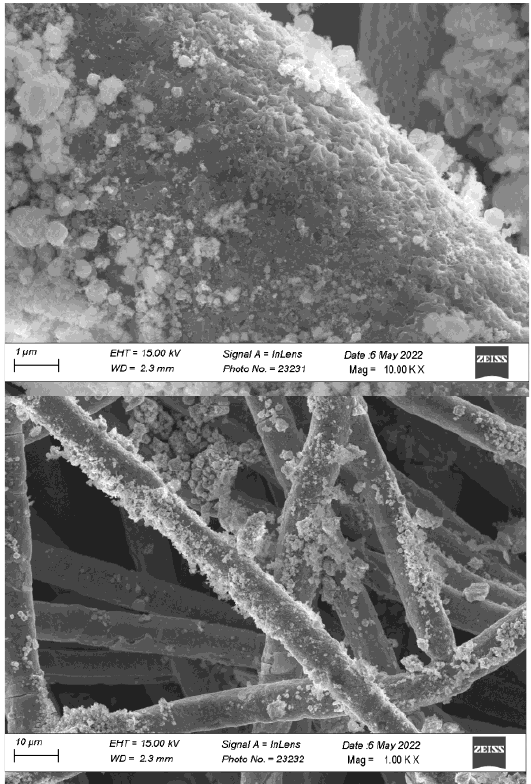
Figure 4. SEM image of an AEM anode obtained by depositing FS prepared cobalt oxide on an AISI-316 sintered metal fiber by EPD followed by sintering at 600°C in air.